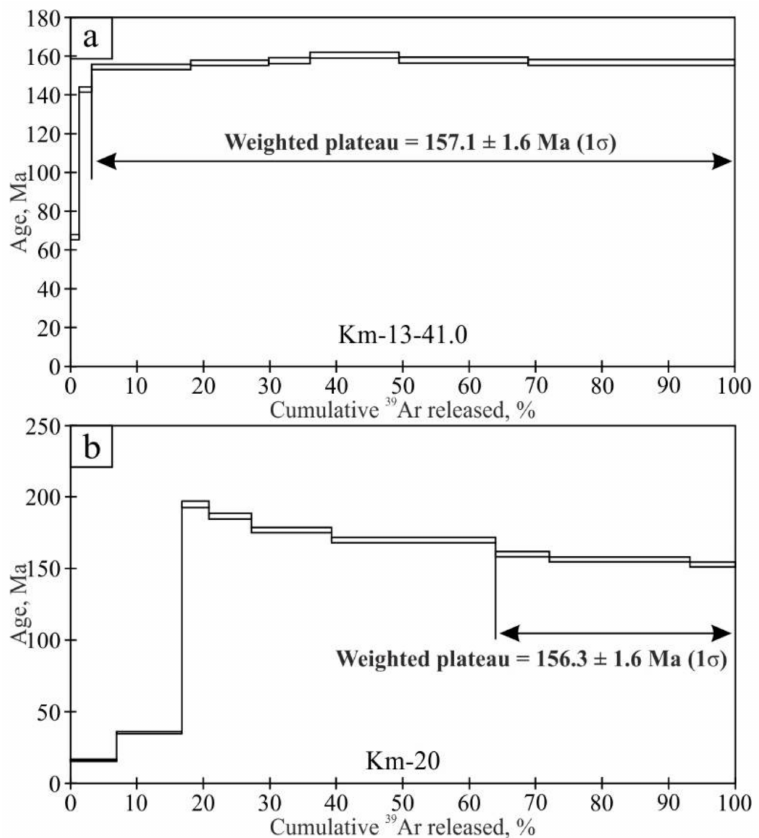
Figure 19. 40 Ar– 39 Ar stepwise heating data of biotite and phlogopite: ( a ) plateau age for biotite from quartz-monzodiorite-porphyry (sample Km-13-41); ( b ) plateau age for phlogopite from retrograde phlogopite